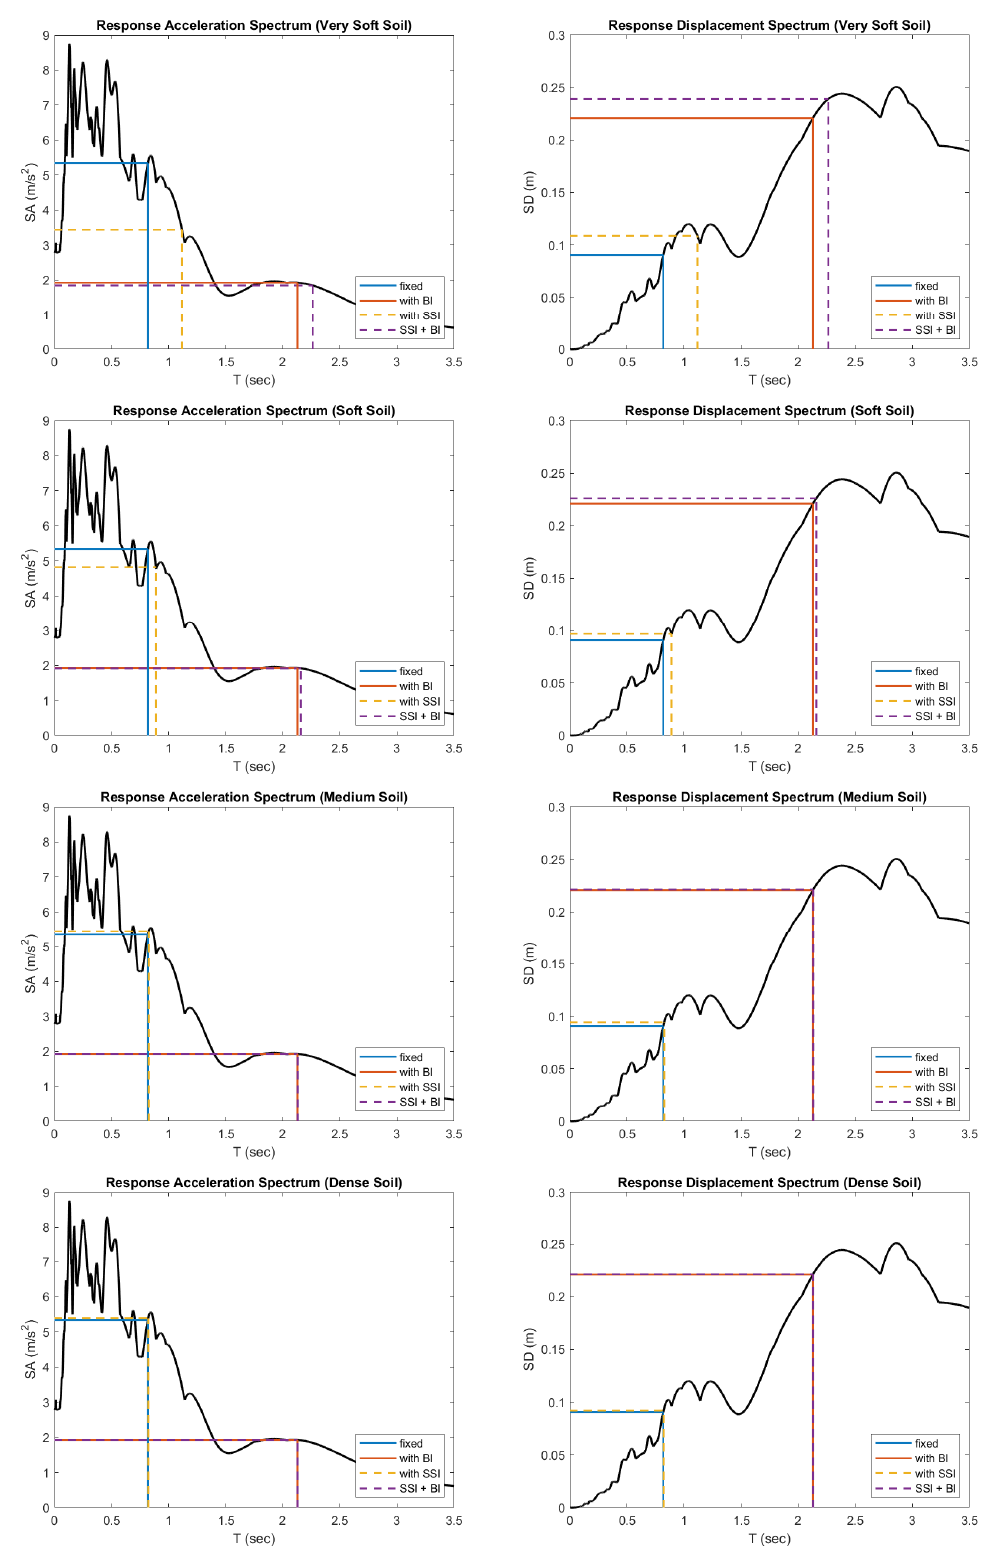
Figure 12. Spectral acceleration and displacement graphics for every soil condition.